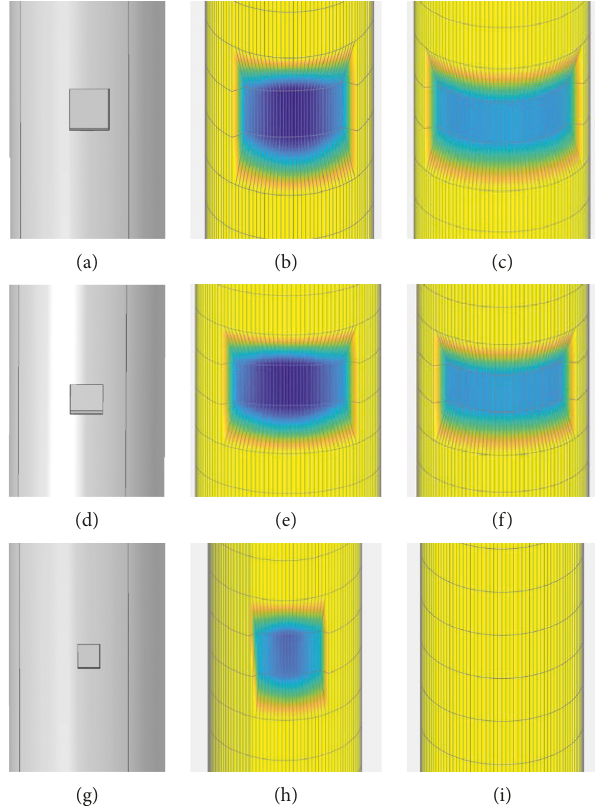
Figure 7: Result of simulation with different sizes. (a, d, g) Actual size of defect, (b, e, h) size determination by the optical fiber method, and (c, f, i) size determination by the conventional method.